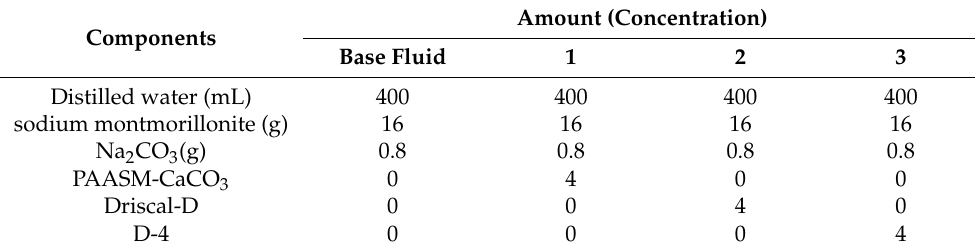
Table 4. Preparation of drilling fluids.